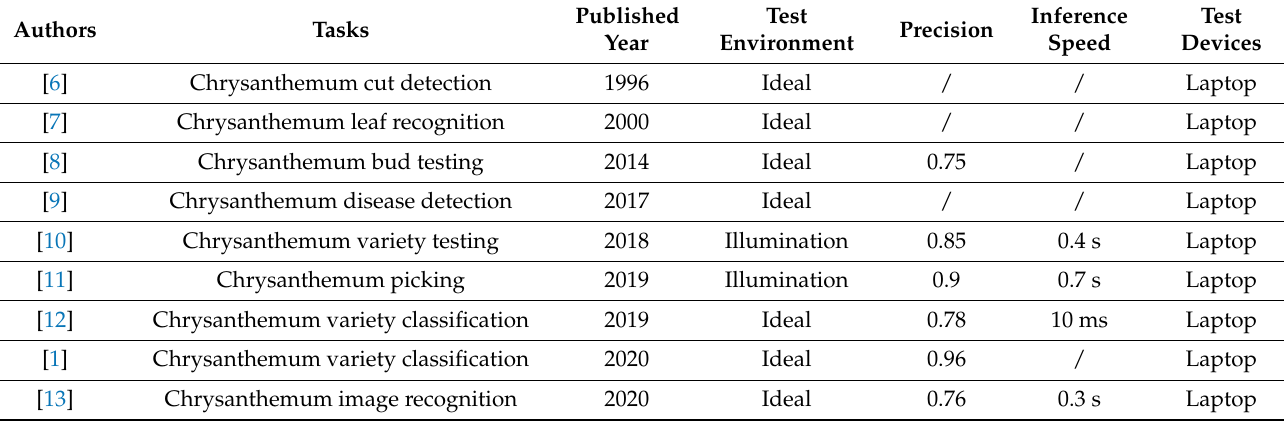
Table 1. The literature on different chrysanthemum detection tasks.